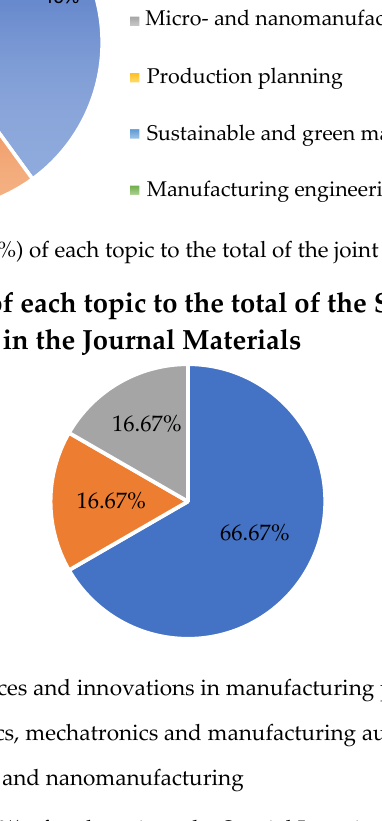
Figure 2. Contribution (%) of each topic to the Special Issue in Materials .